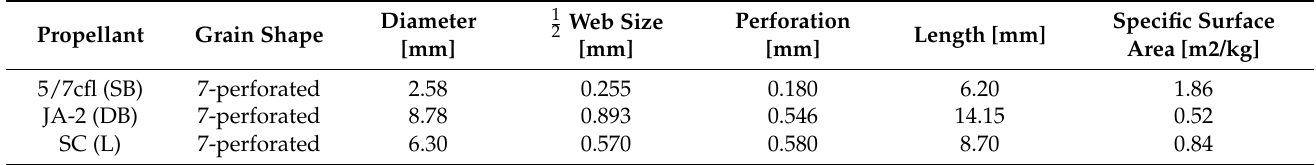
Table 1. Average dimensions of propellant grains.